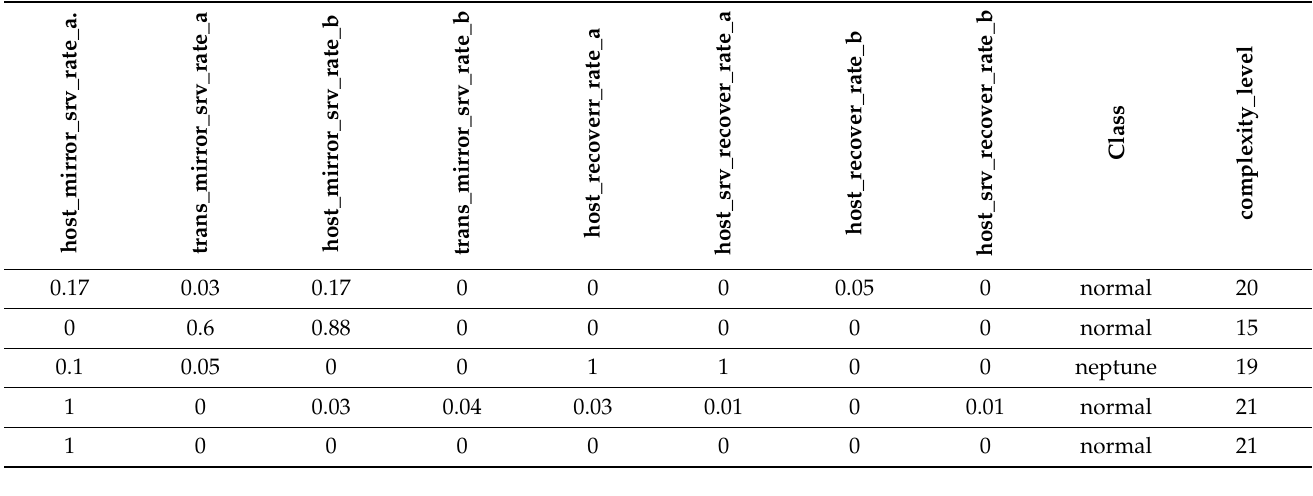
Table 7. Training Set Results.